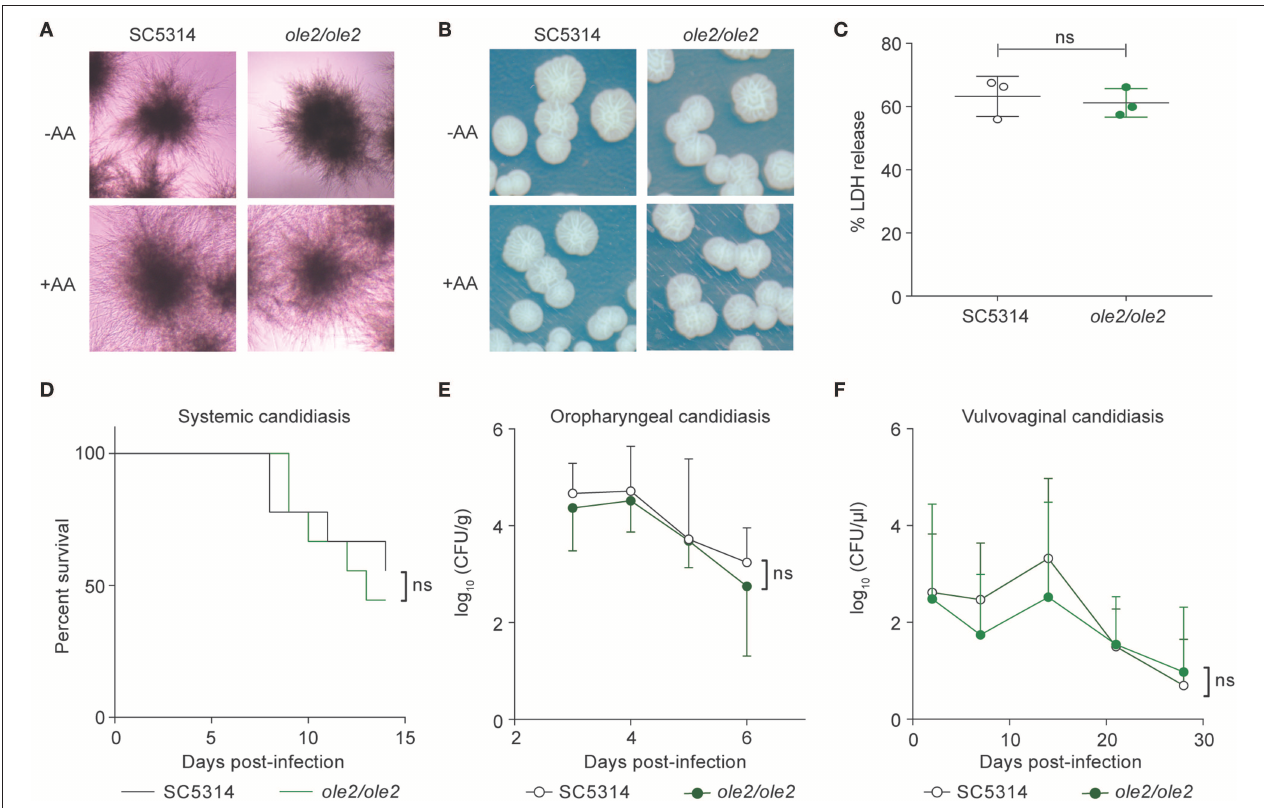
FIGURE 3 | Fungal PGE 2 is not required for virulence. (A,B) Hyphae formation of the WT and ole2/ole2C. albicans strains in response to fetal calf serum (FCS) (A) or when plated on Spider agar. (B) AA was added where indicated. (C) In vitro cytotoxicity of the indicated fungal strains to J774A.1 murine macrophages, determined by quantifying the release of lactate dehydrogenase (LDH) from the macrophages. Data presented as a percentage of the maximal amount of LDH released by completely lysed cells. (D) Survival of mice infected intravenously with 2 × 10 5 cells of the indicated C. albicans strains. (E,F) Kinetics of the fungal CFUs in the tongue (E) and vaginal lavage fluid (F) of mice infected sublingually (E) or intravaginally (F) with the indicated fungal strains. Data pooled from 2 independent experiments. Mean ± s.d. (C,E,F) . n = 8–10 mice/group. ns, not significant. Student’s t- test (C,E,F) ; Log-rank test (D)